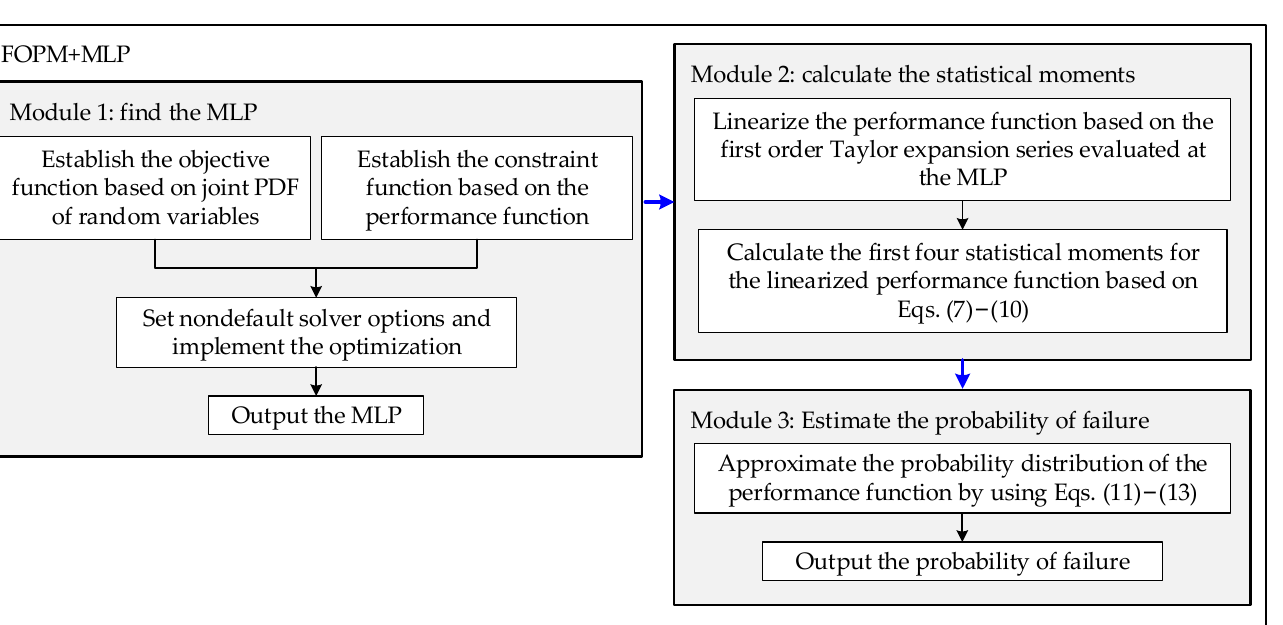
Figure 1. Flowchart of the proposed approach 1.